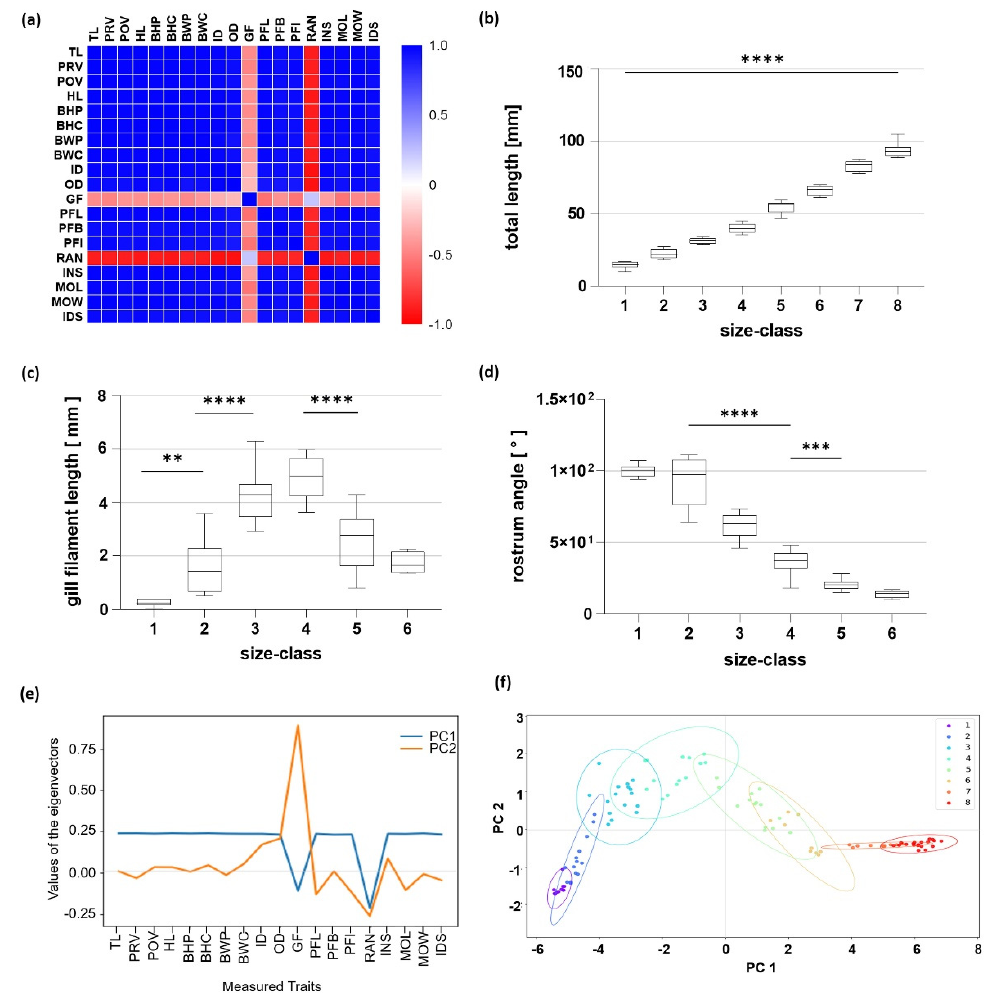
Figure 3. Analysis of morphometric features. ( a ) Correlation matrix of the obtained body parameters. The values for the Pearson correlation coefficient are color coded. ( b – d ) Changes in selected body parameters of Scyliorhinus canicula with increasing size classes from total length ( b ), gill filament ( c ), and rostrum angle ( d ). Significant changes are indicated by ** p < 0.01, *** p < 0.005, **** p < 0.001. ( e , f ) Results of the principal component analysis. ( e ) Values of the eigenvectors for the first two principal components (PCs). Contribution of the parameters to each PC is shown by the value of the eigenvector. ( f ) Plot of the first two PCs. Results are shown for each size class (color coded).